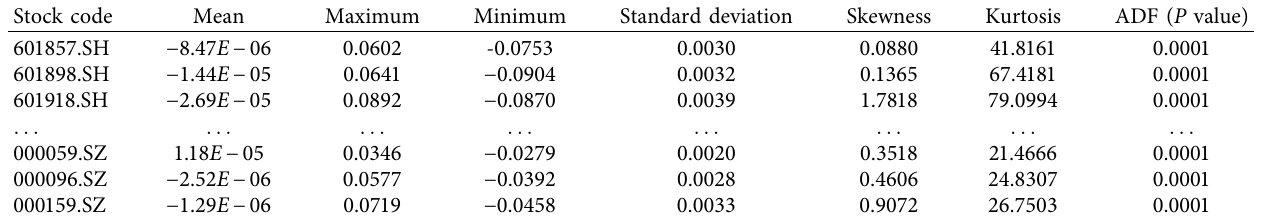
Table 1: Statistical characteristic of the sample.